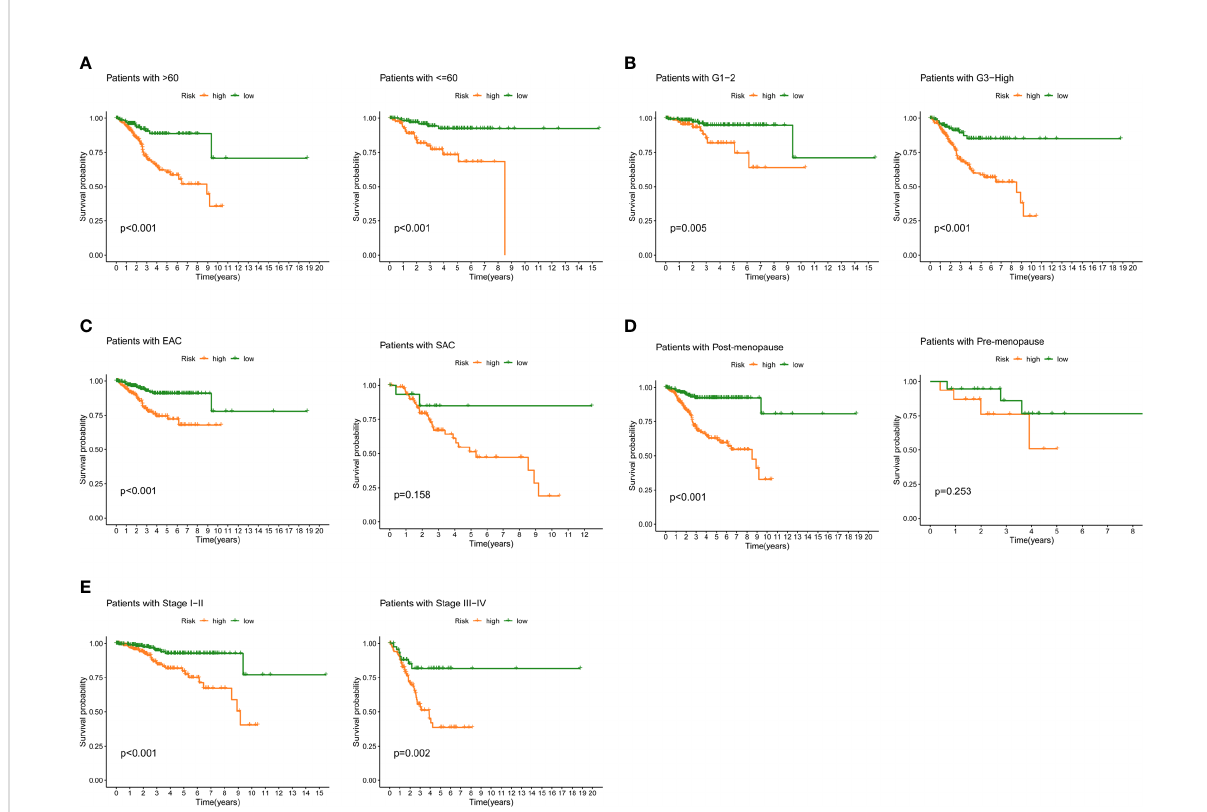
FIGURE 5 Prognostic power in different clinical subgroups. K-M curve analyses for patient subgroups, including (A) age, (B) grade, (C) histological type, (D) menopause, (E) stage. K-M: